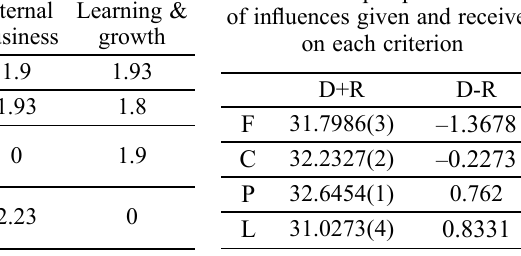
Table 4. The initial influence matrix A for perspectives Financial Customer